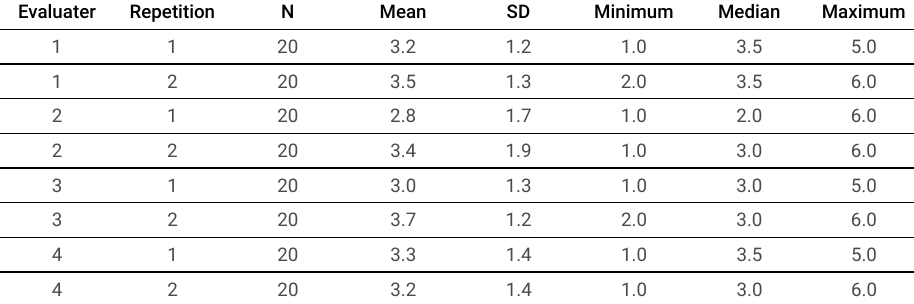
Table 1. Measurements of position and dispersion of skeletal maturation per evaluator and repetition.